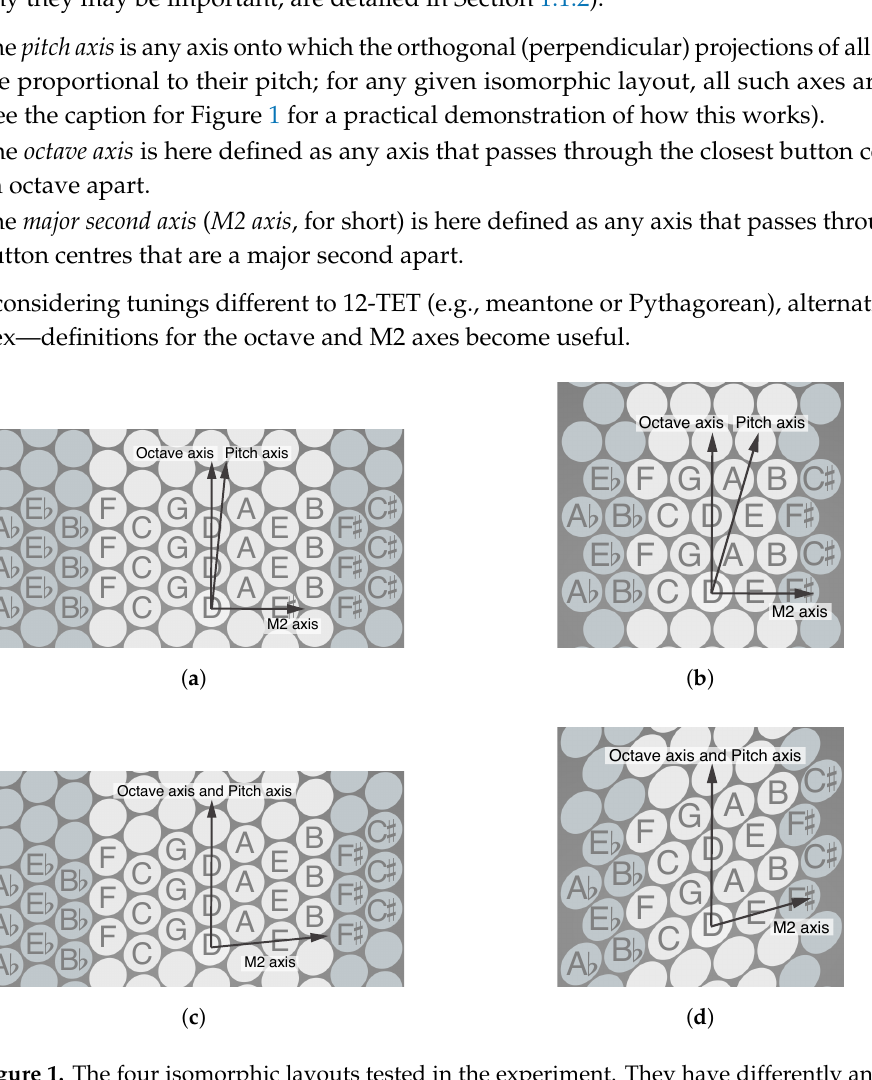
Figure 1. The four isomorphic layouts tested in the experiment. They have differently angled pitch axes and major seconds axes. An easy way to understand the meaning of the pitch axis is to place a ruler on any of the above subfigures so that it is at right angles to the pitch axis. If the ruler is then slid in the direction of the pitch axis, with its angle kept constant, the button-centres passing under the ruler’s edge will always be encountered in ascending pitch order. This occurs only when the ruler is oriented and moved, in this way, with the pitch axis. This means that, when the pitch axis is vertical, as in ( c , d ), the pitch of each button is proportional to its vertical position. In all four layouts, the octave axis is vertical; that is, buttons that are an octave apart are vertically aligned. ( a ) A (cid:48) S (cid:48) : nonadjacent M2s, unsheared; ( b ) AS (cid:48) (the Wicki layout [4]): adjacent M2s, unsheared; ( c ) A (cid:48) S : nonadjacent M2s, sheared; ( d ) AS : adjacent M2s,